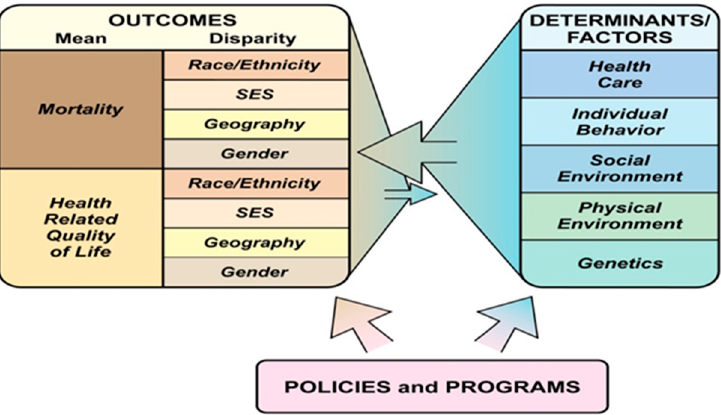
Figure 1. What is population health? [13].